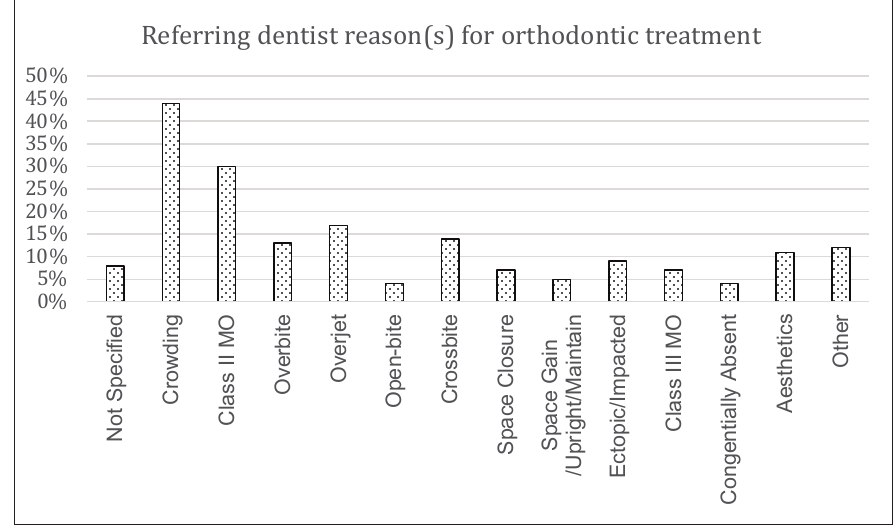
Figure 3. Summation of clinical reasons for referring to orthodontist. This figure included multiple reasons when Figure 3. evident on the clinical records/referring letter if applicable for a particular patient. Not specified related to referrals to orthodontists with the request to address the patient’s orthodontic needs without exact specification of the